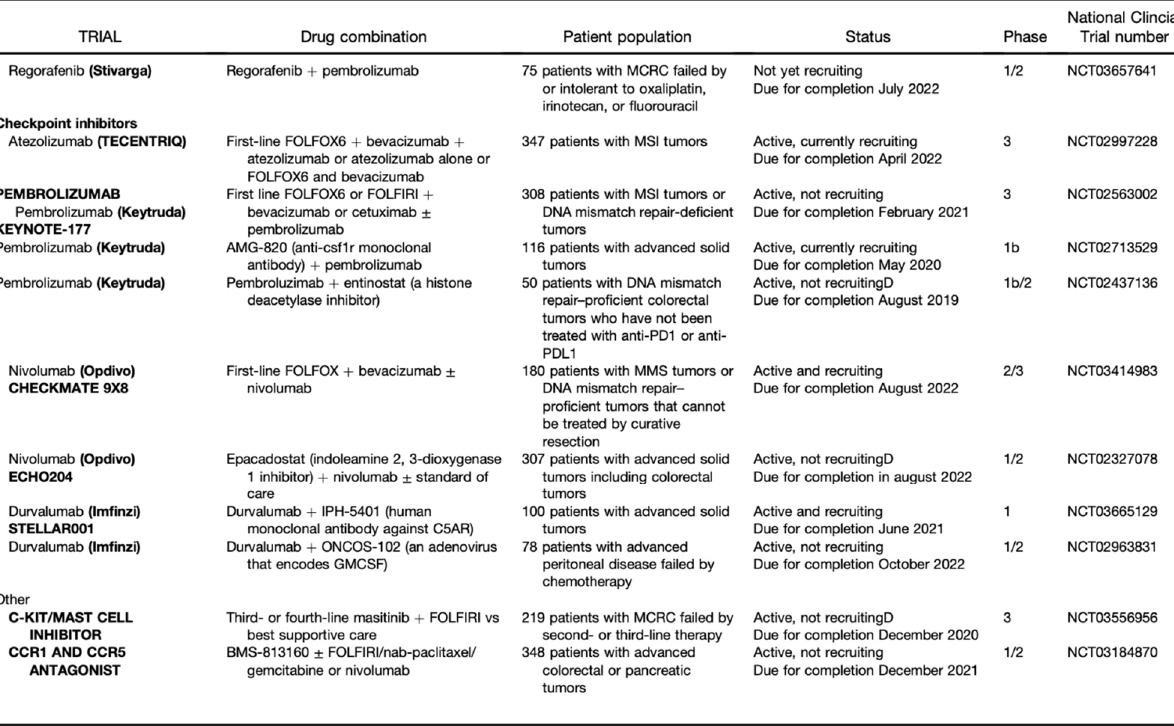
Figure 3. Part II: Clinical Trials of Agents Designed to Target Tumor Stroma. From Fridman et al [9].